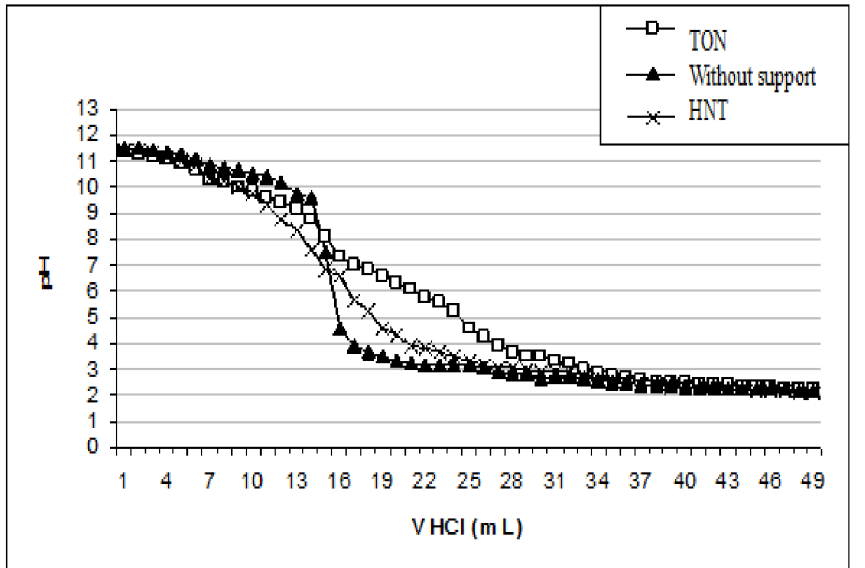
Figure 10. Titration curves of NaOH (0.01 mol L − 1 )/NaCl (0.1 mol L − 1 ) solution by HCl (0.1 mol L − 1 ) in the absence and presence of 1 g of the material (HNT et TON).